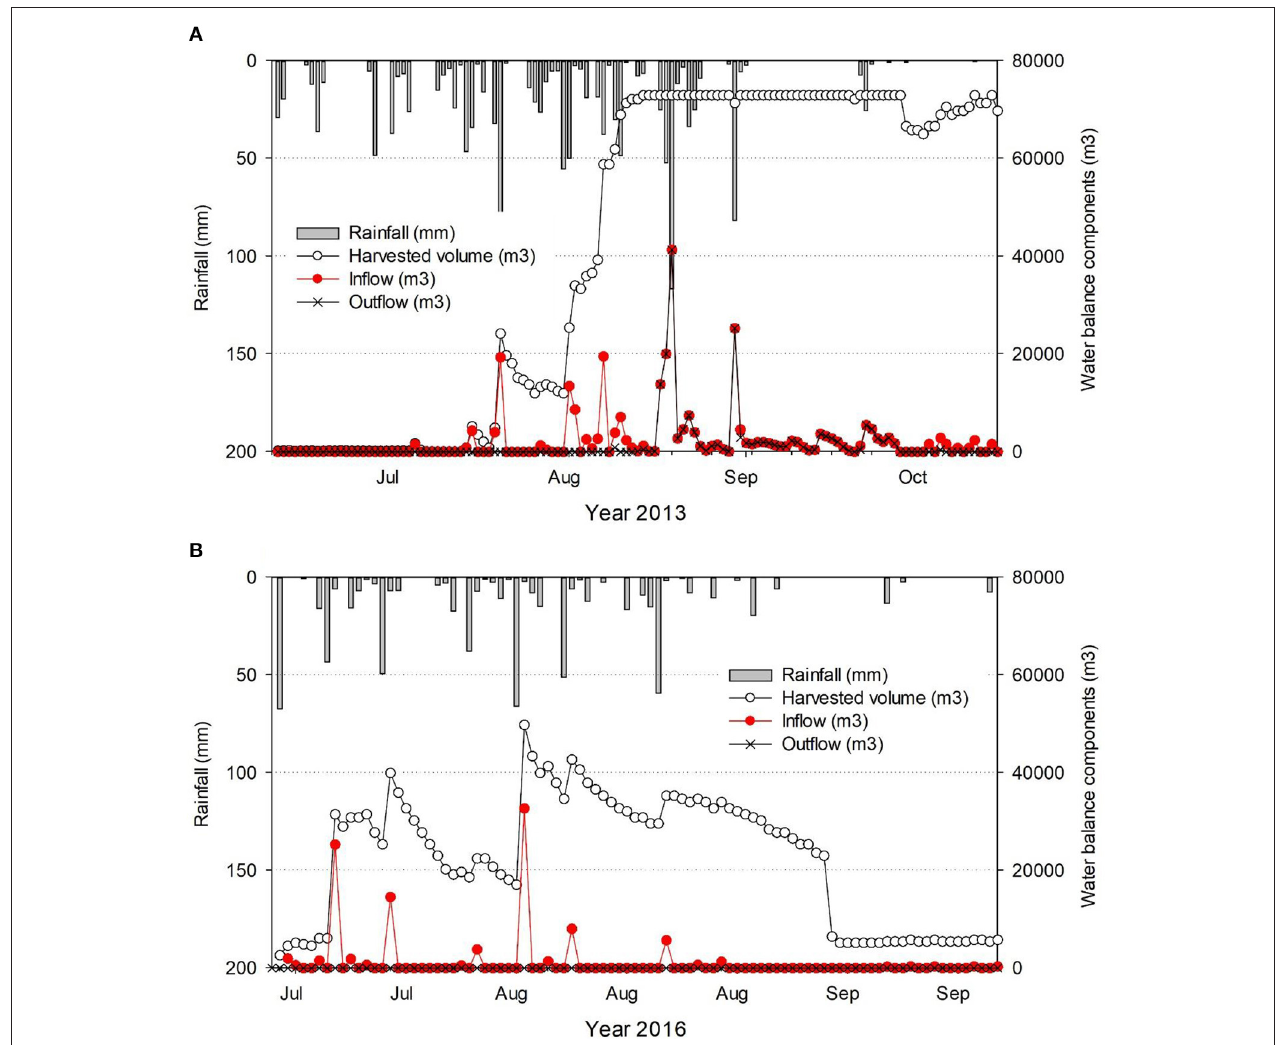
FIGURE 6 | Haveli water balance during (A) wet (2013) and (B) normal (2016)